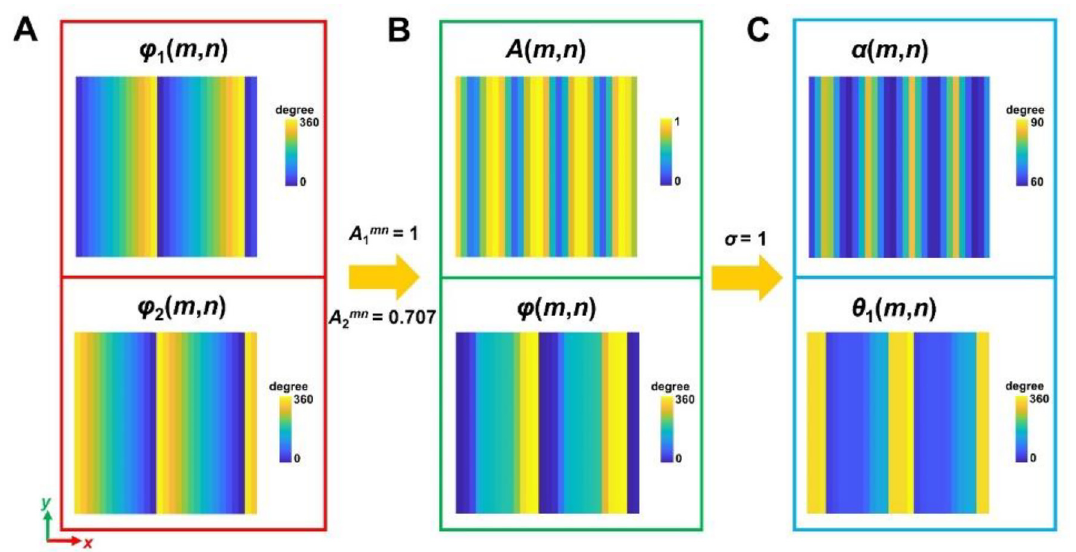
Figure3: Designprocesstoobtaintheproposedreflectivemetasurfaceforindependentlycontrollingtheradiationdirectionandpowersofthe beams. (A) The phase distributions for the desired beams. (B) The corresponding amplitude and phase distributions with the parameters A 1 mn = 1 and A 2 mn = 0.707. (C) The calculated distributions of geometric parameters α mn and θ 1 mn for σ =